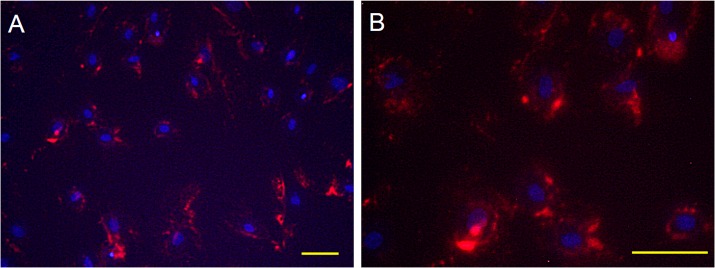
Detection of labeled MSCs in vitro.A, B: Photographs of labeled MSCs in vitro. Fluorescent microscope detected MSCs with red-colored cytoplasm. Scale bar: A: 40μm; B: 20μm. The cell labeling rate was 71.4±5.7% at 2 hours after cell labeling (n = 12).